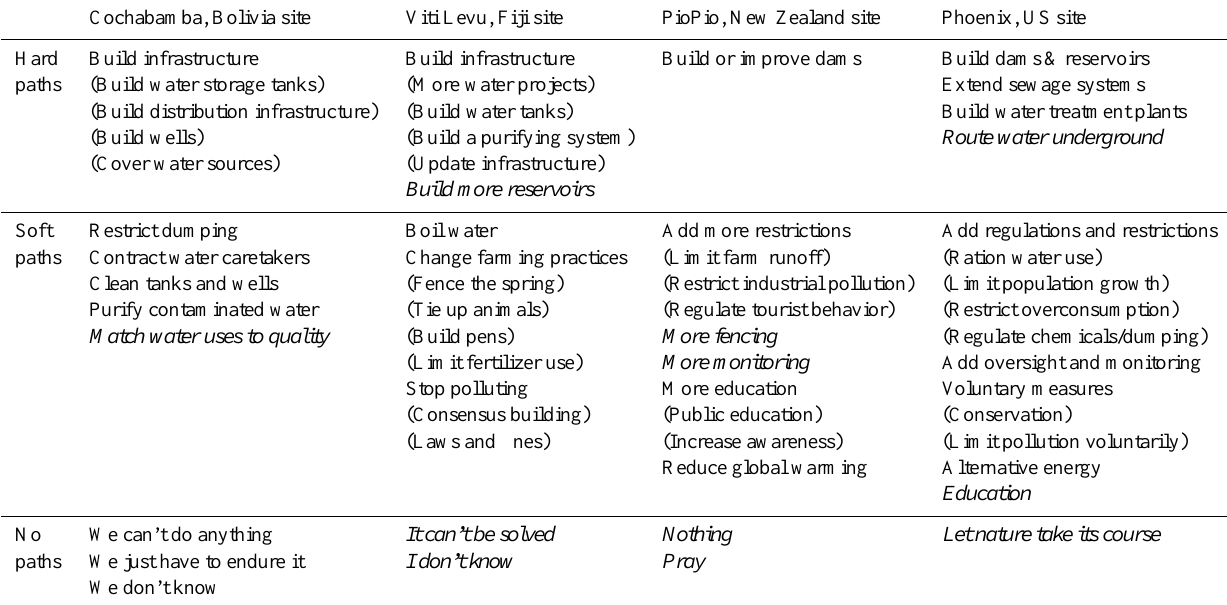
Table 2. Water solutions in four cross-cultural sites: a summary of themes, subthemes (in parentheses), periphery themes (in italics). Cochabamba, Bolivia site Viti Levu, Fiji site PioPio, New Zealand site Phoenix, US site Hard Build infrastructure Build infrastructure Build or improve dams Build dams&reservoirs Extend sewage systems